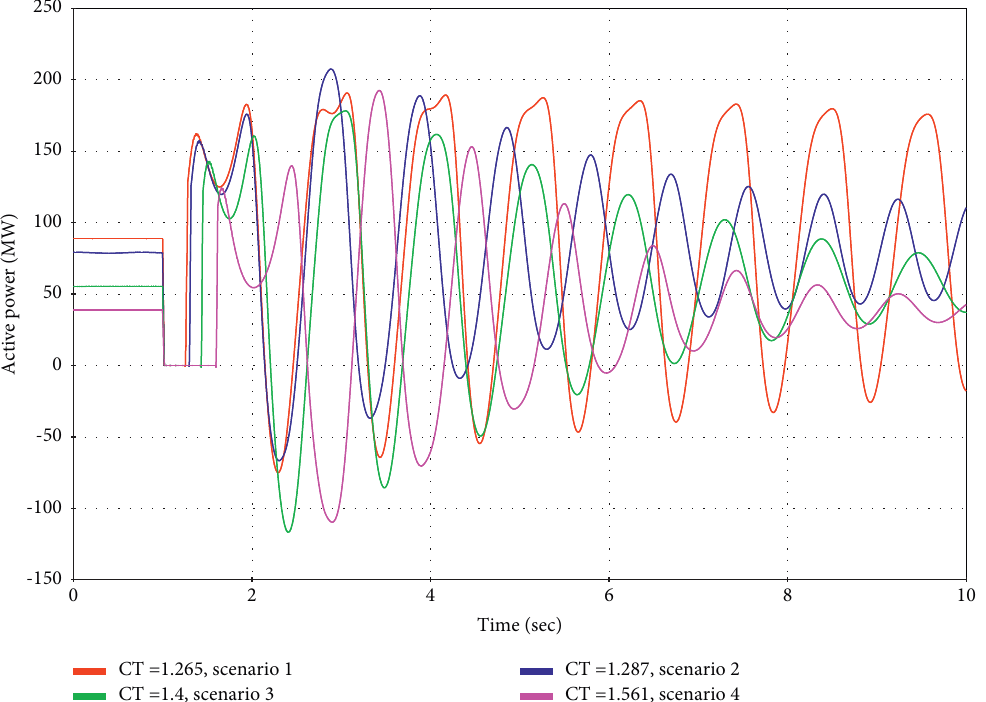
Figure 9: Transmitted power from bus 2 to bus 3 for diferent generated power when CT � CCT.